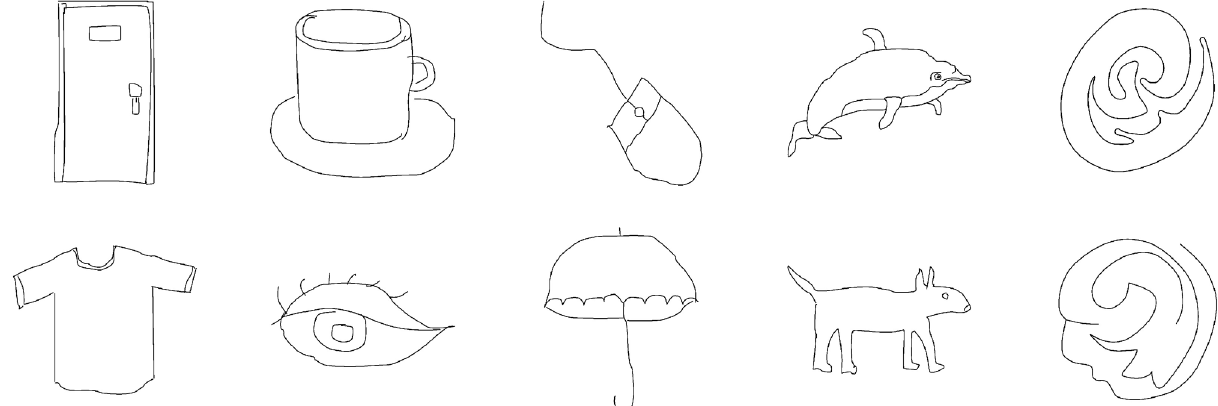
Fig. 3 Stimulus images. The left eight images were downloaded from the MIT saliency benchmark [7] and binarized. The two rightmost images are meaningless shapes from Ref. [28]. From upper left to lower right: Door, Cup, Mouse, Dolphin, Meaningless shape 1 (MS1), T-shirt, Eye, Umbrella, Dog, and Meaningless shape 2